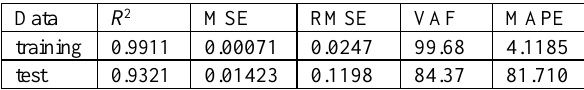
Table 2. SVR-CBBO Performance for prediction of